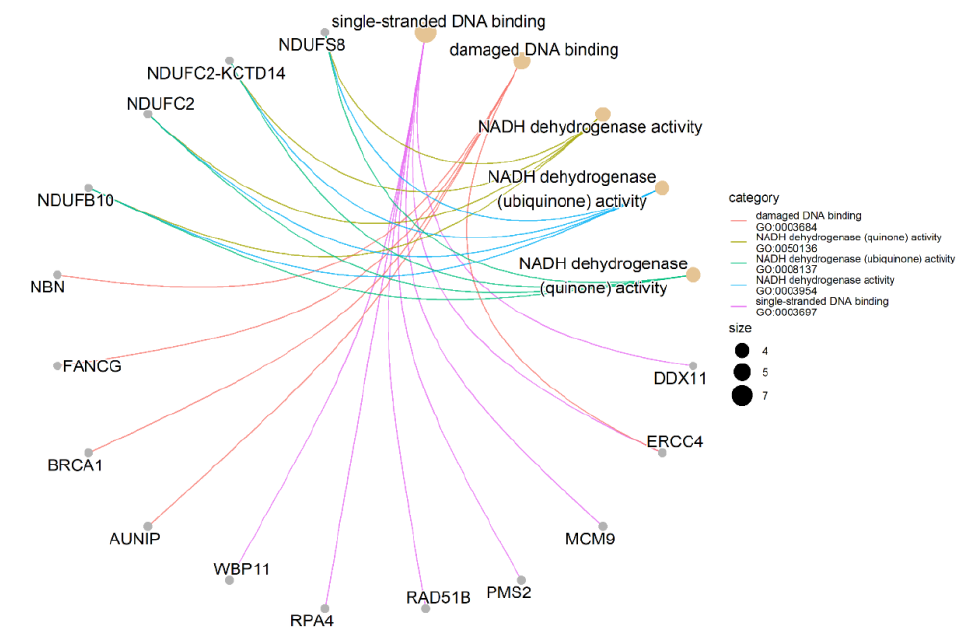
Figure 2. Gene-concept network of identified genes. It shows the enriched concepts, obtained with a p -value cut-off of 0.05 (Gene Ontology biological processes) linked to the genes involved in each concept, and the relationship between them when genes are involved in more than one process. The size of the concept nodes depends on the gene count involved in that